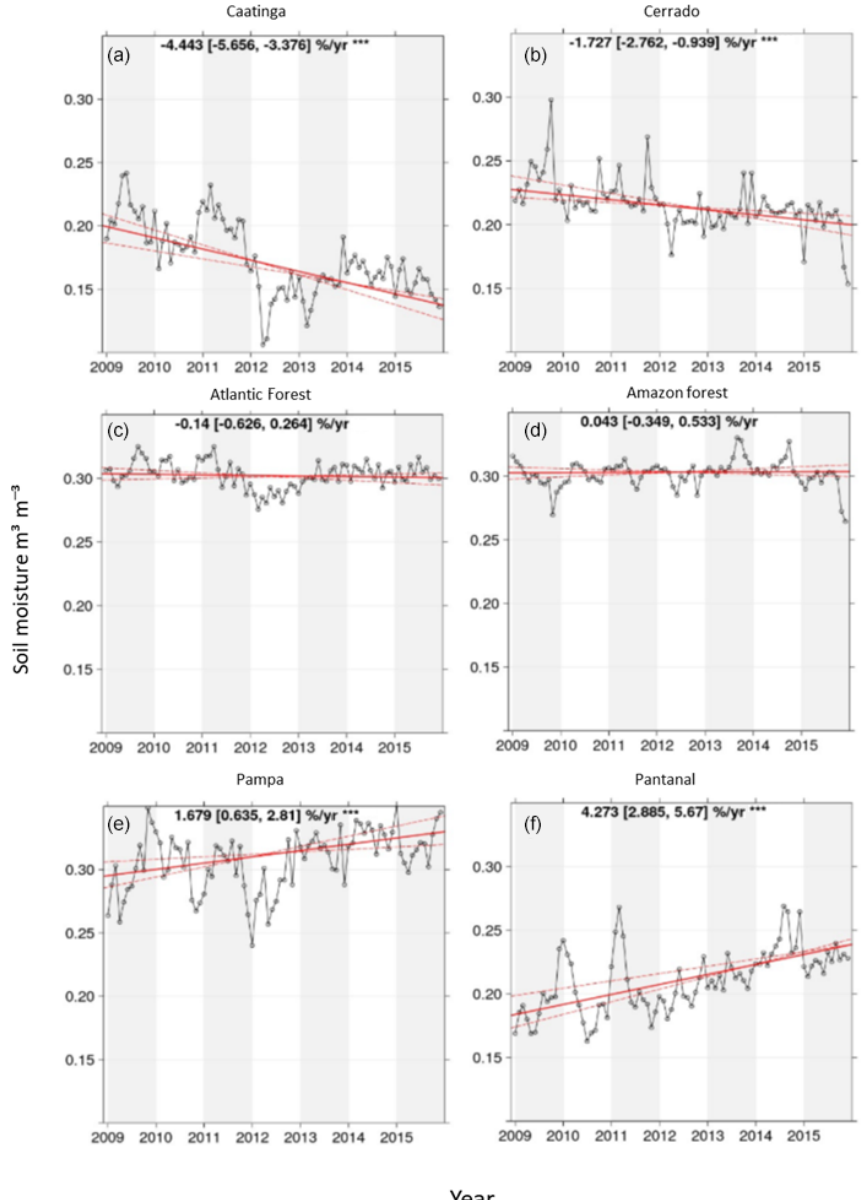
Figure 5. Soil moisture trends across Brazil. (a) Caatinga ( n = 921), (b) Cerrado ( n = 2410), (c) Atlantic Forest ( n = 1394), (d) Amazon ( n = 4819), (e) Pampa ( n = 231 ) and (f) Pantanal ( n = 179). The values in every graph show the slope percentages of changes. Red solid lines show the mean trend, and red dashed lines show the standard deviation trend. ∗∗∗ ( p < 0 .